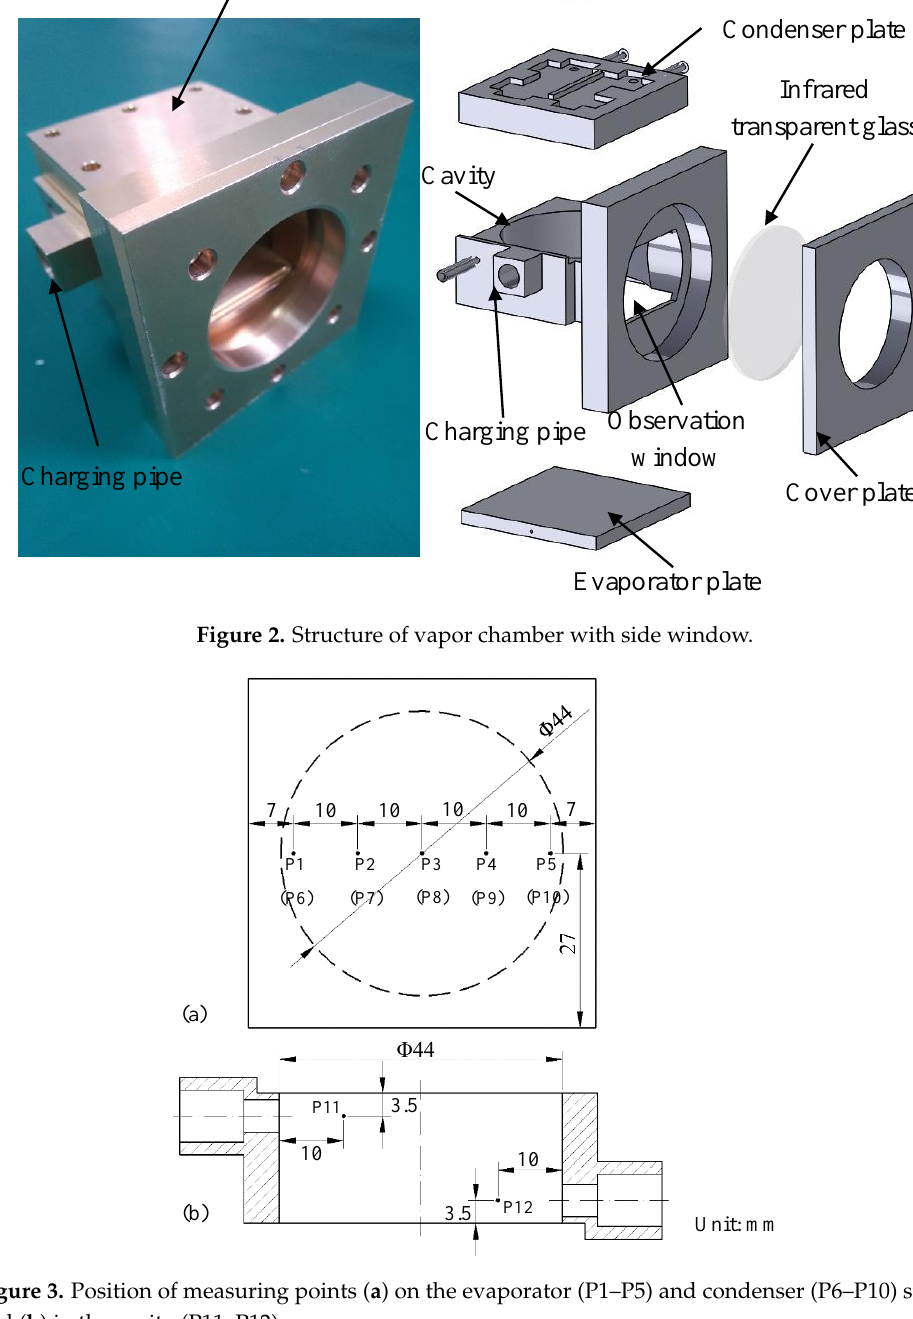
Figure 3. Position of measuring points ( a ) on the evaporator (P1–P5) and condenser (P6–P10) surface and ( b ) in the cavity (P11, P12).